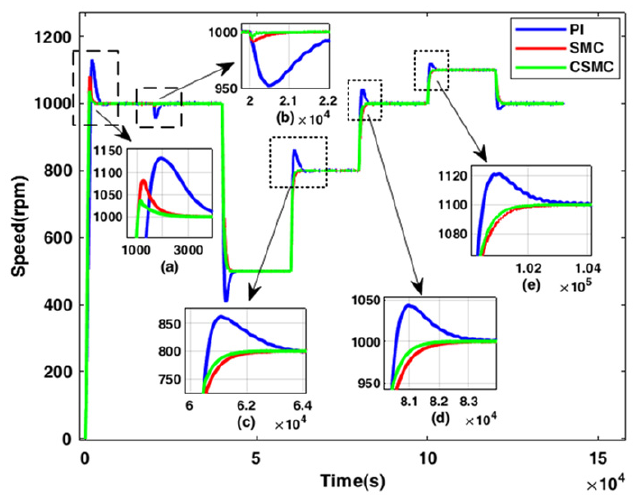
Figure 10. Performance response under speed step with 5 N · m torque: ( a ) starting performance, ( b ) disturbance rejection ability, ( c )–( e ) starting performance at different step speeds.